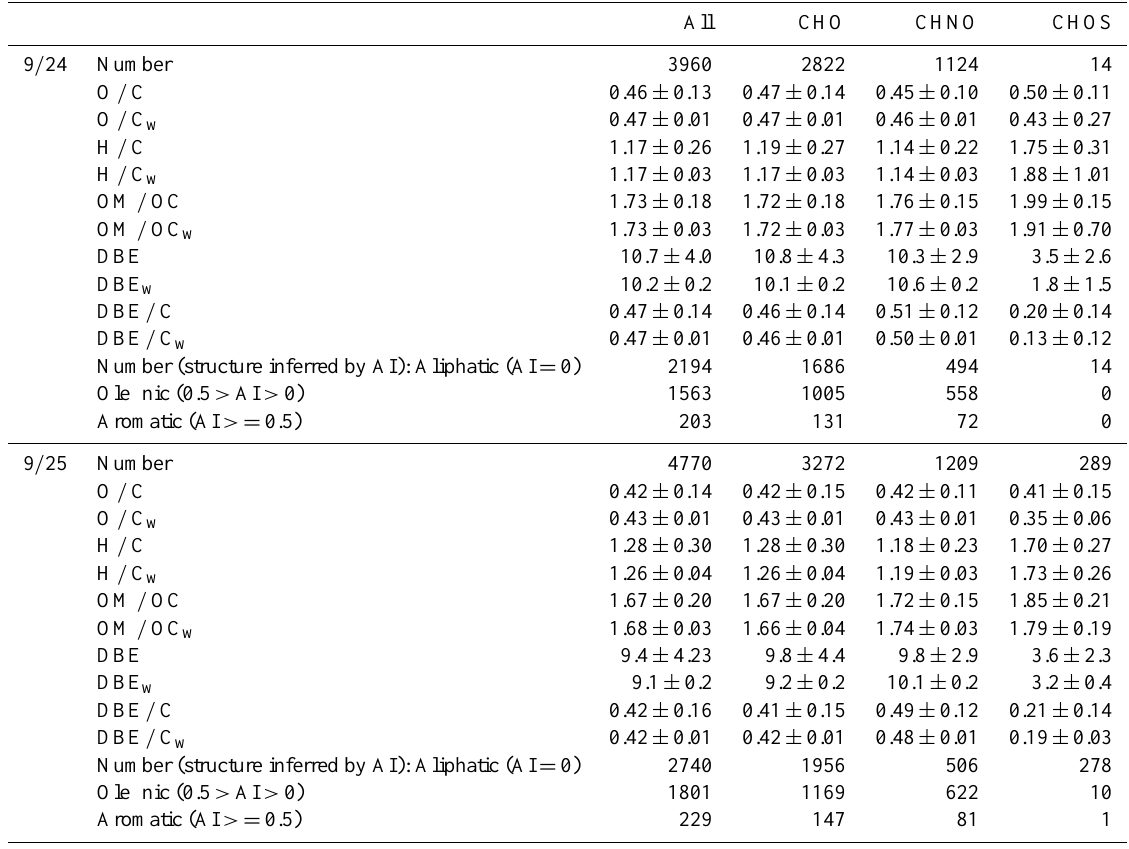
Table 2. Chemical characterization of the molecular assignments detected in WSOM for 9 / 24 and 9/25. Averages of three replicate analyses (O / C, H / C, OM / OC, DBE and DBE / C) with calculated standard deviation (1 σ) of each data subset are given. Subscript “w” denotes values weighted by relative abundance, which have propagated standard error computed using the standard deviations for each subset (as described in Mazzoleni et al., 2012; Zhao et al.,